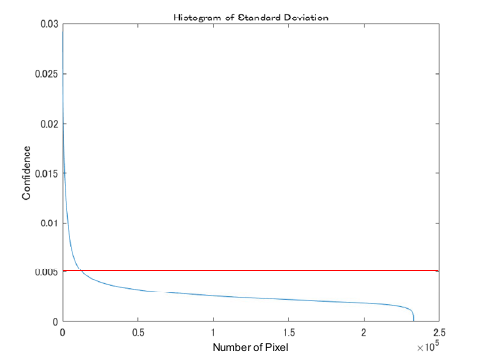
Figure 15. Histogram of standard deviation of focus value